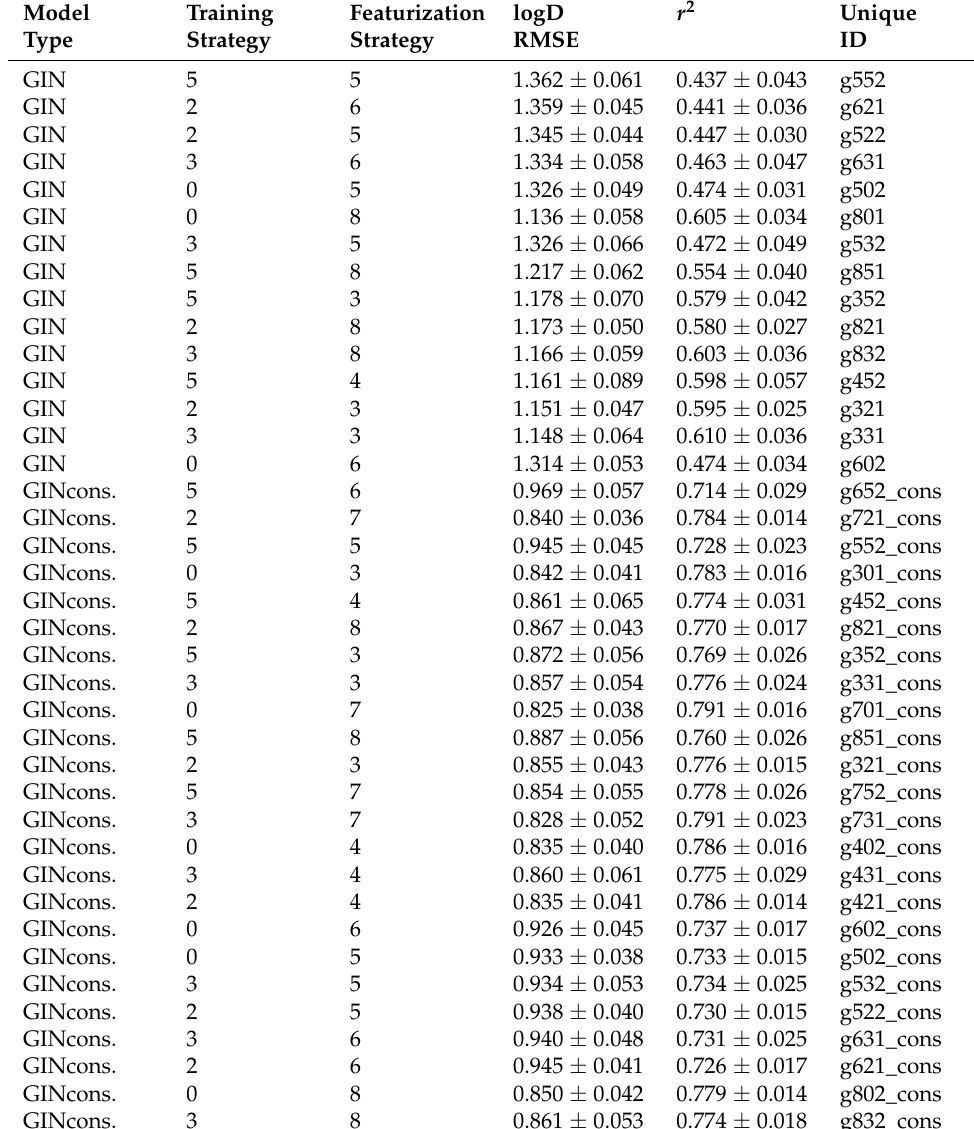
Table A14. Cont. Model